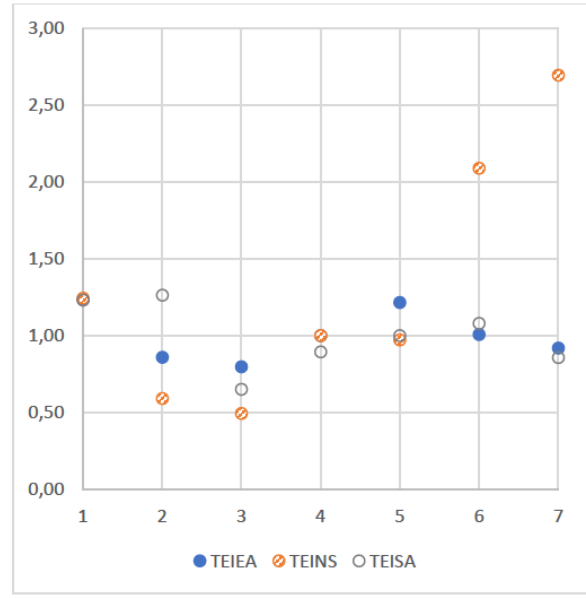
Figure 3: Comparison of projects in terms of TEI deviation